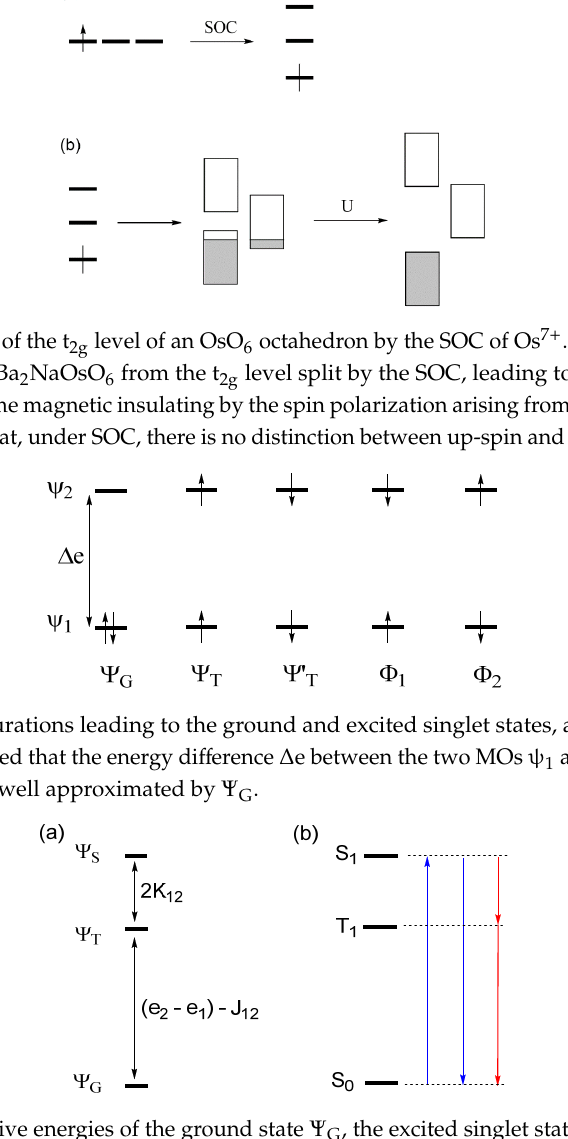
Figure 17. ( a ) The split of the t 2g level of an OsO 6 octahedron by the SOC of Os 7+ . ( b ) The formation of the t 2g block bands of Ba 2 NaOsO 6 from the t 2g level split by the SOC, leading to a magnetic metallic state (left), which become magnetic insulating by the spin polarization arising from the on-site repulsion of Os 7+ (right). Note that, under SOC, there is no distinction between up-spin and down- spin electrons.